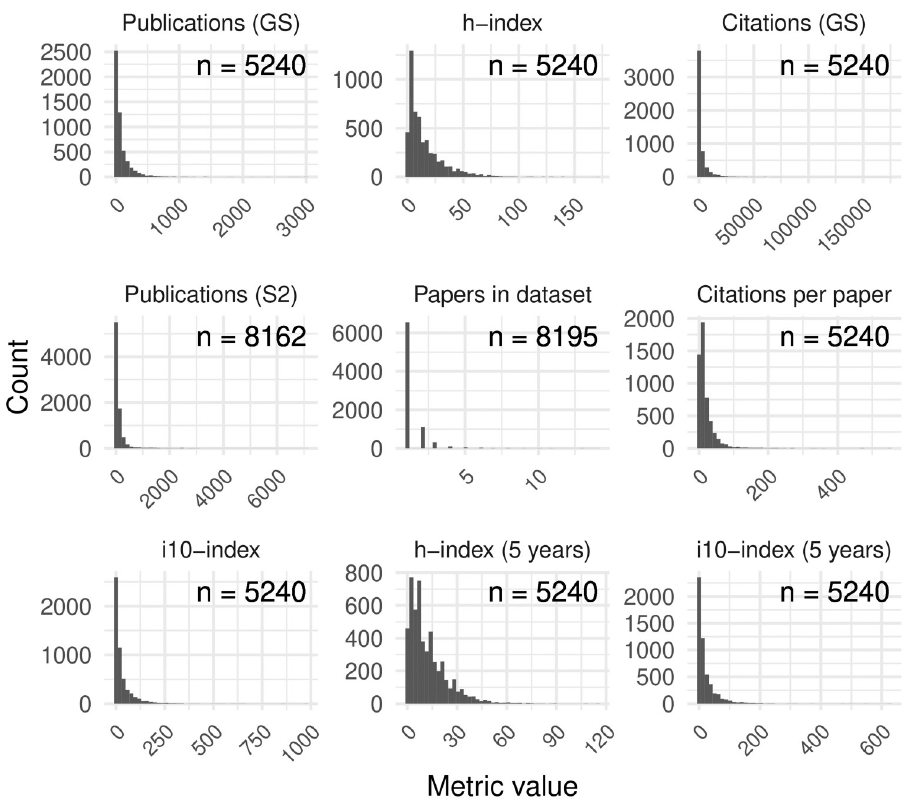
Fig 1. Histograms of the author-level prestige proxies. The number of non-missing values (n) is provided for each variable.